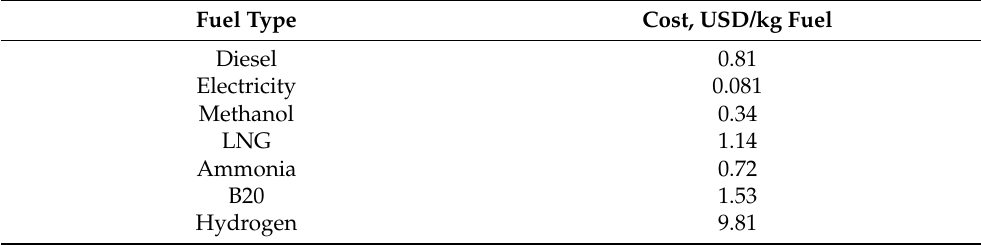
Table 2. Fuel prices in 2020 [11].